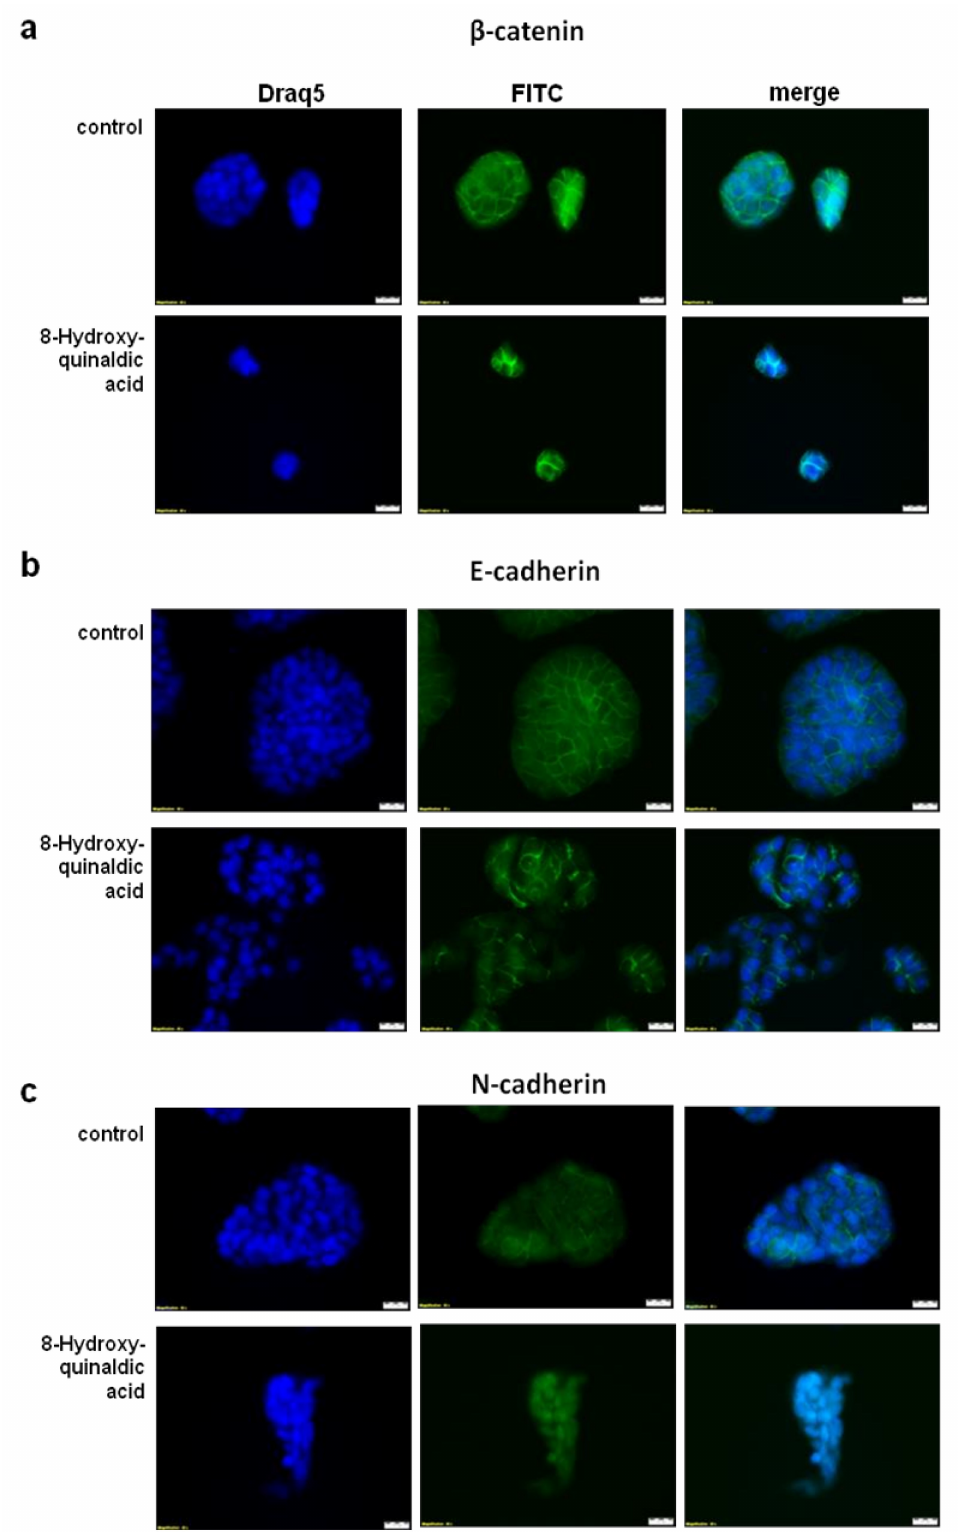
Figure 8. The e ff ect of 8-hydroxyquinaldic acid on cellular localization of β -catenin ( a ), E- ( b ) and N-cadherin ( c ) in HT-29 cells. Immunofluorescent staining for β -catenin and E- and N-cadherin in HT-29 cells exposed to 8-hydroxyquinaldic acid (1 mM) for 48 h (control; not treated). Cell nuclei were labeled with cell permeable fluorescent DNA dye DraQ5. Magnification was 40 ×